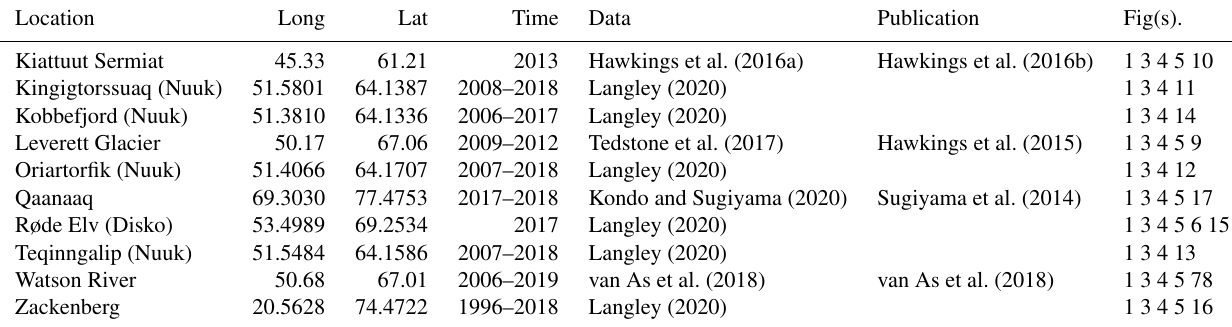
Table 1. Table of observation locations, time spans, and associated references. Coordinates are decimal degree W and N. Location Long Lat Time Data Fig(s). Kiattuut Sermiat 45.33